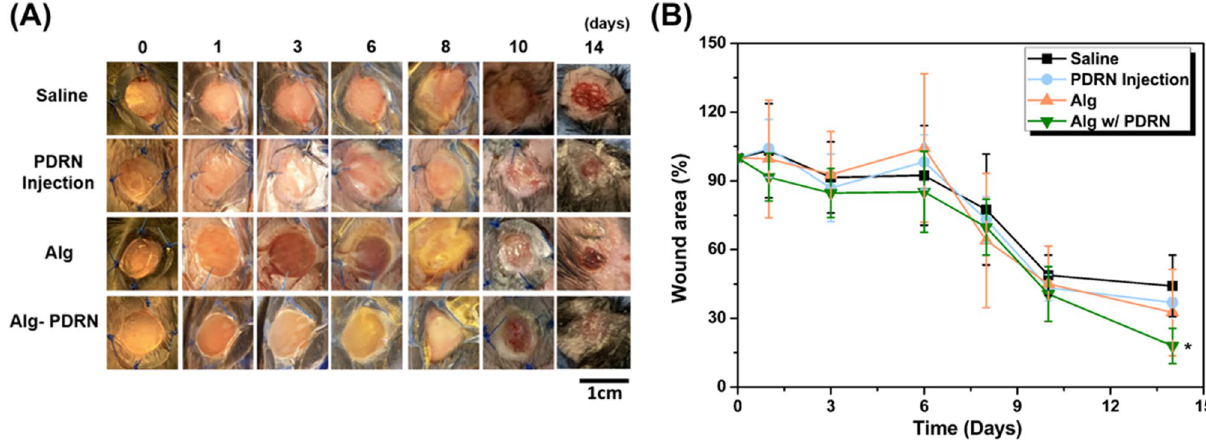
Figure 6. Healing rate of saline, PDRN injection, Alg and Alg-PDRN treated wound: ( A ) macroscopic appearance of the excised wound at different time points and ( B ) the remaining wound area after 1, 3, 6, 8, 10 and 14 days of treatment (n = 5, * p <